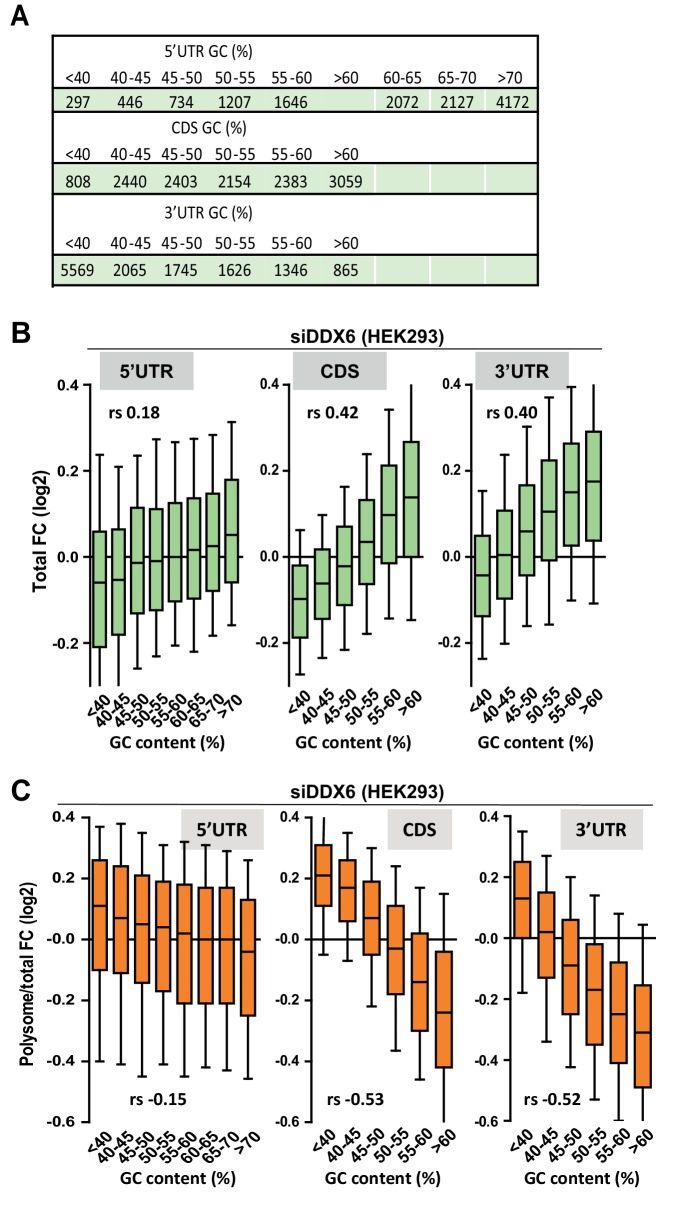
Impact of the GC content on DDX6-dependency.(A) Number of transcripts in the different classes analyzed in (B) and (C). (B,C) mRNA abundance (B) and translation derepression (C) following DDX6 silencing in HEK293 cells mostly depends on the GC content of their CDS and 3’ UTR. The analysis was performed as in Figure 1D, using the polysomal/total mRNA ratio as a proxy measurement of translation rate. In (B), the Spearman correlation coefficients (rs) 0.40, 0.42 and 0.18 are significantly different from each other (p<0.0001). In (C), −0.52 and −0.15 are significantly different (p<0.0001), while 0.53 and 0.52 are not (p=0.37).